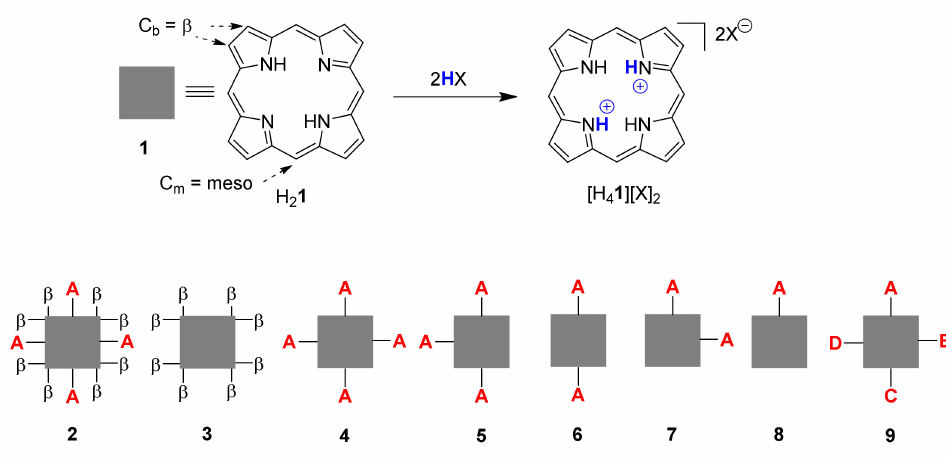
Figure 1. Illustration of porphyrin dication formation and general types of porphyrin substitution